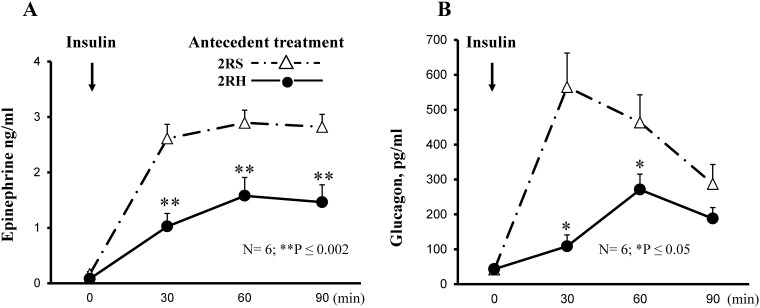
Plasma hormonal responses during the hypoglycemic clamp.A) Epinephrine (ng/ml) and B) glucagon (pg/ml) responses in twice daily recurrently hypoglycemic (2RH) rats and in the corresponding saline group (2RS). Data are summarized from three independent experiments, n = 6 animals per group. Values are shown as mean ± SE, *p <0.05 or **p<0.002 vs. corresponding control at given time point.